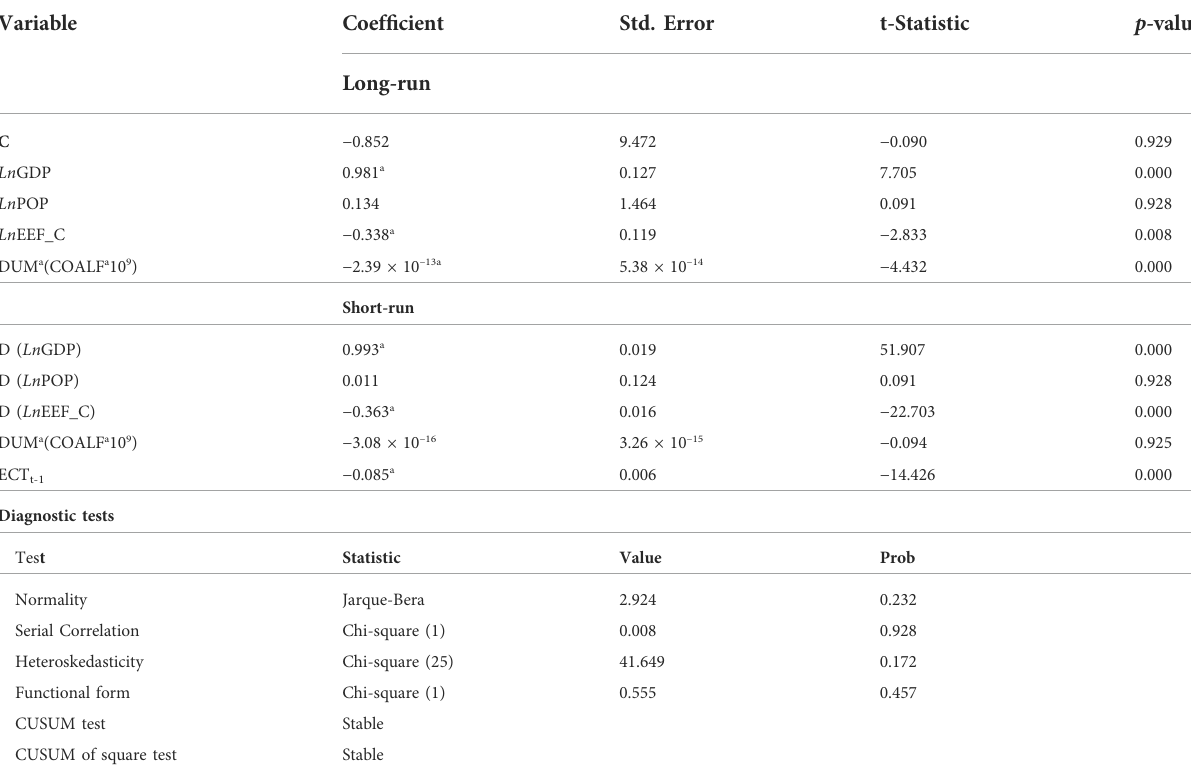
TABLE 10 ARDL results for the Coal power plant (dependent variable =